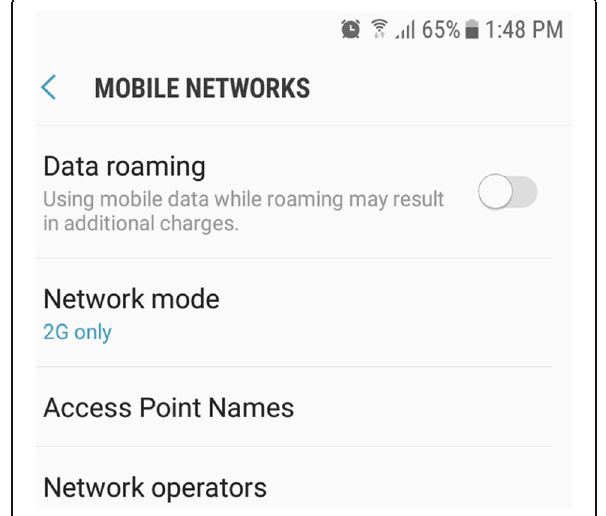
Fig. 19 2G configuration view of the mobile